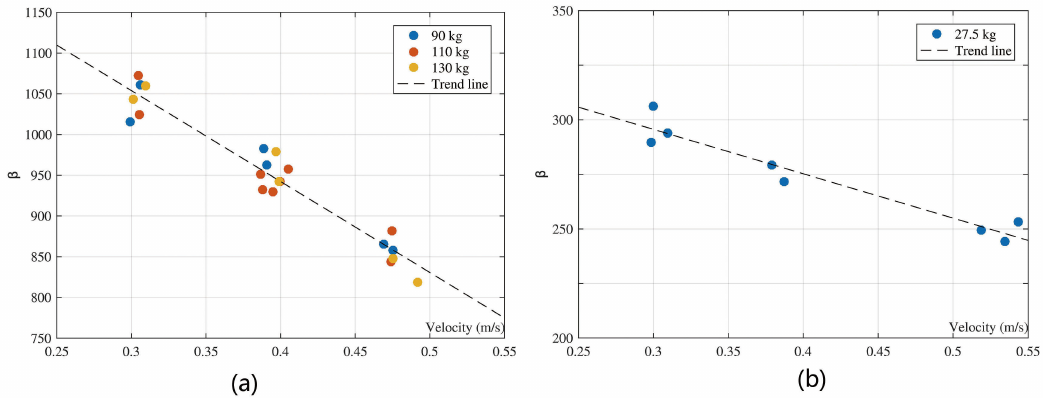
Figure 14. Normalizing factor for the structure under moving load at ( a ) node 1 of the intact bridge and ( b ) node 1 of the intact beam.